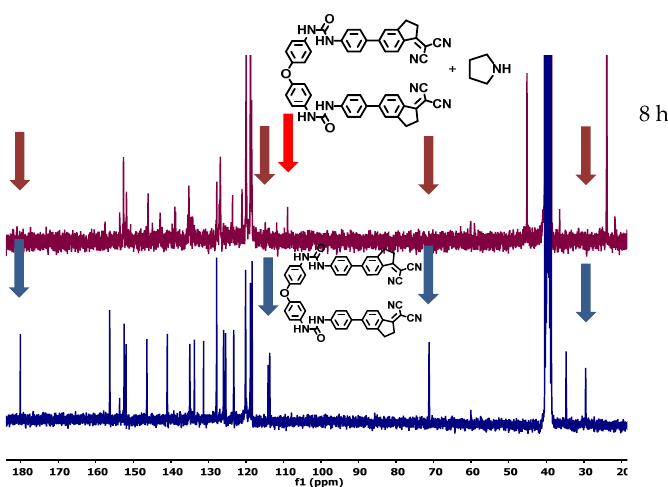
Figure 7. Evolution of the 13 C NMR spectrum of equimolecular solutions (2.5 × 10 − 3 M) of 1 + pyrrolidine in DMSO- d 6 .